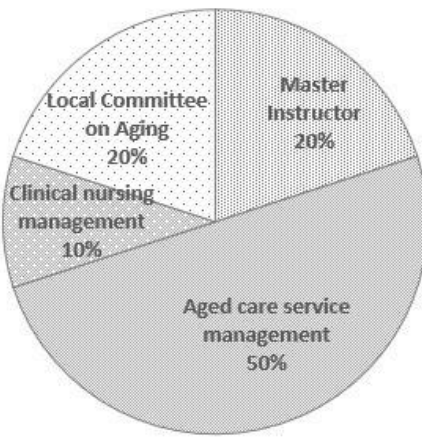
Figure 2. Expert areas of expertise.